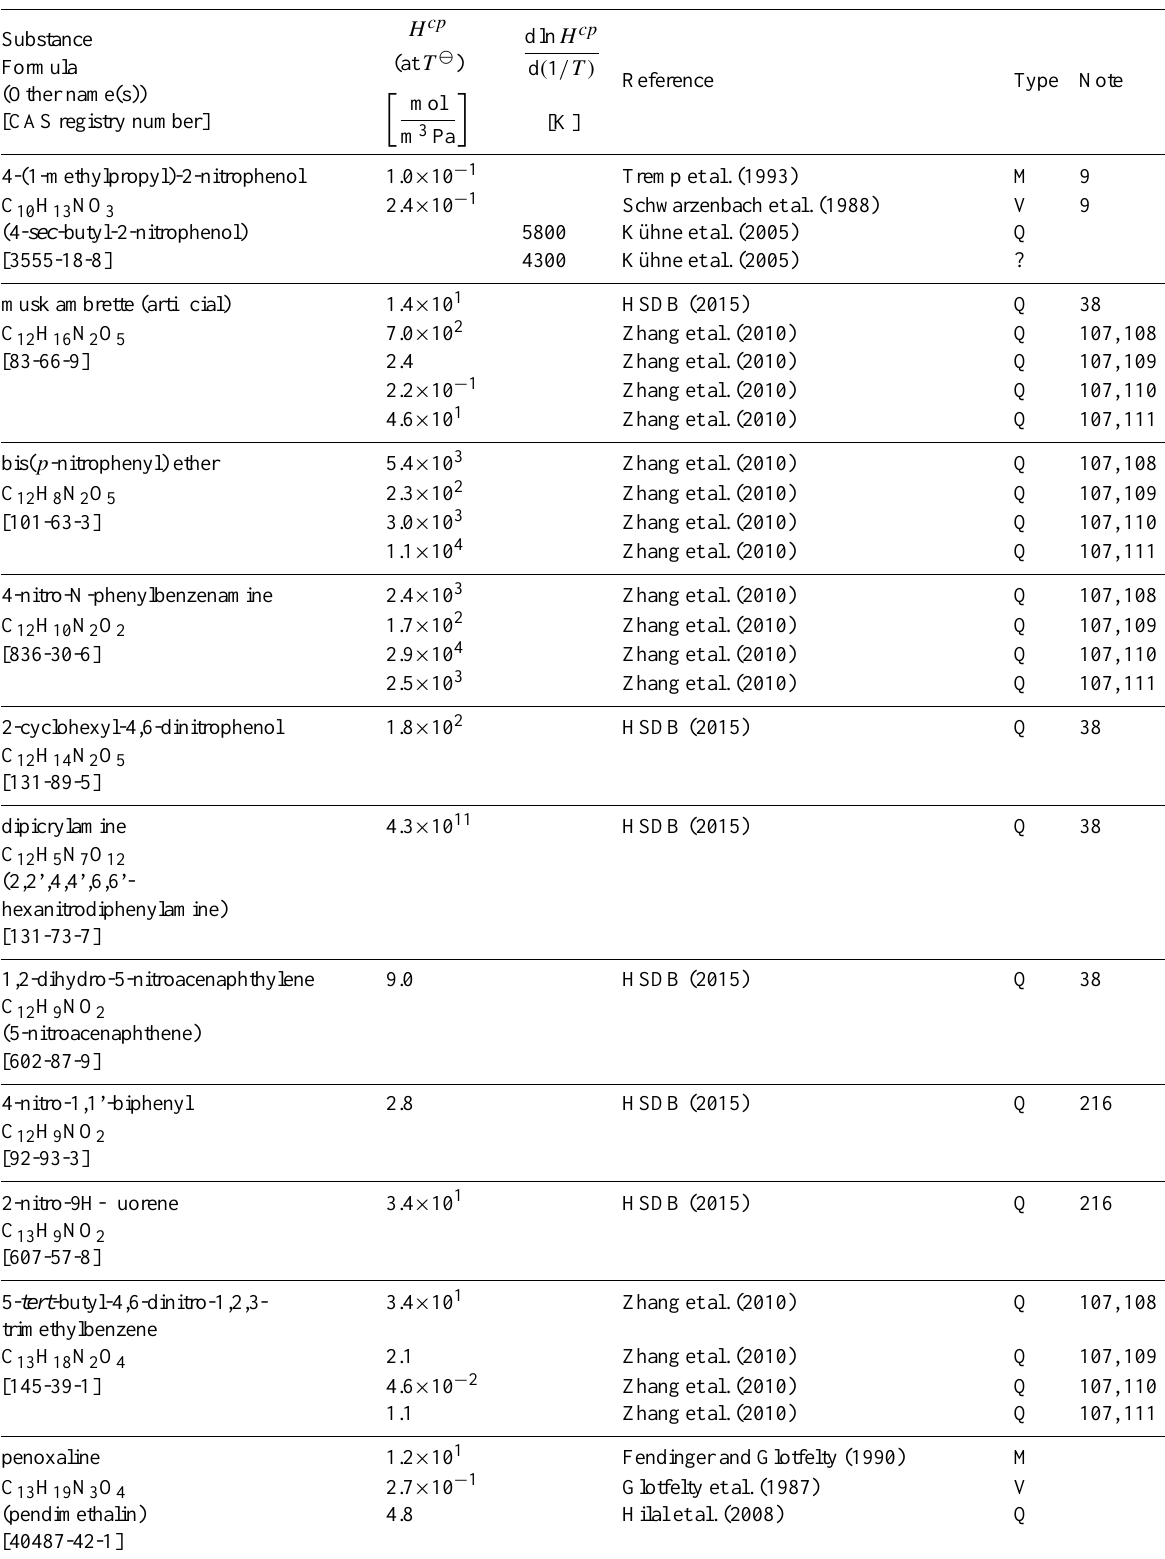
Table 6: Henry’s law constants for water as solvent